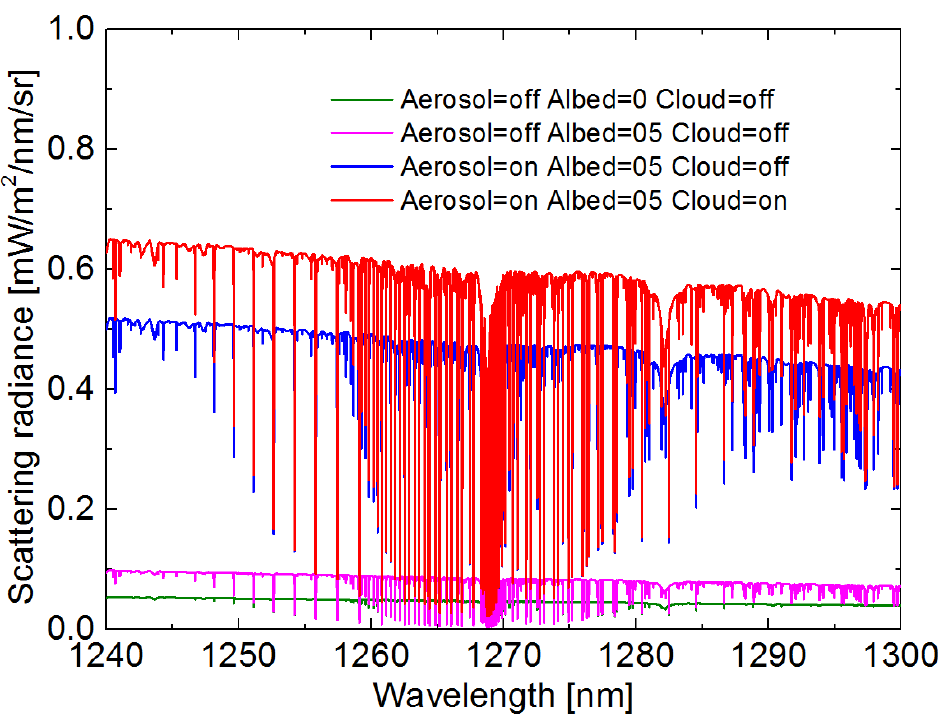
Figure 6. The spectral brightness of the limb atmospheric scattering at the tangent height of 35 km for different situations of aerosol, albedo, and cloud.